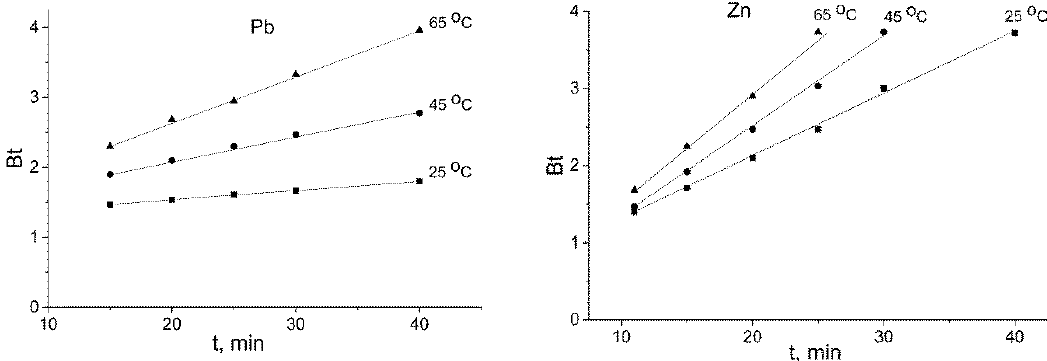
Figure 10. Boyd’s plots for lead and zinc sorption on titanium phosphate at 25–65 °C (the initial concentration of Pb 2+ and Zn 2+ was 10 mmol·L −1 ). Table 4. Kinetic parameters of the intraparticle diffusion model for Pb 2+ and Zn 2+ ion sorption at different temperatures on titanium phosphate (the initial concentration of Pb 2+ and Zn 2+ was 10 mM·L −1 ).